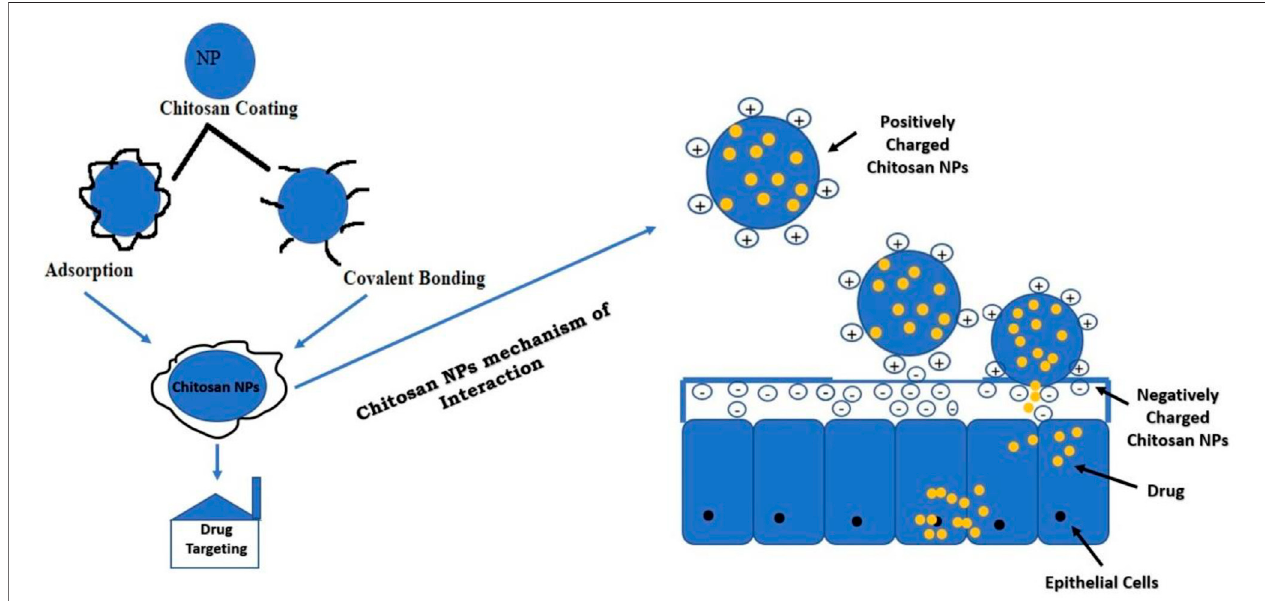
FIGURE 5 | Strategies of NP modi fi cation with chitosan for drug delivery. NP, nanoparticle.